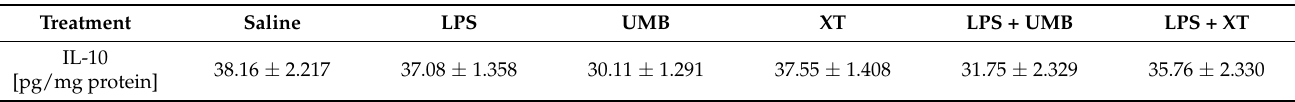
Figure 5. Effects of acute injection of LPS (0.8 mg/kg) and repeated xanthotoxin (XT, 15 mg/kg) and umbelliferone (UMB, 15 mg/kg) alone or in combination on tumor necrosis factor (TNF- α ) in the brain. LPS (0.8 mg/kg, i.p.) was administered on the day 1, XT and UMB were administered repeatedly (day 1–7). The brains were collected 24 h after the last injection; n = 6; the means ± SEM; ** p < 0.01 vs. saline-treated control group, ˆ p < 0.05, ˆˆ p < 0.01 vs. LPS treated control group; Bonferroni’s test. Table 1. Effects of acute injection of LPS (0.8 mg/kg) and repeated xanthotoxin (XT, 15 mg/kg) and umbelliferone (UMB, 15 mg/kg,) alone or in combination on interleukin 10 (IL-10) in the brain. LPS (0.8 mg/kg, i.p.) was administered on the day 1st, XT and UMB were administered repeatedly (day 1–7). The brains were collected 24 h after the last injection; n = 6; the means ±